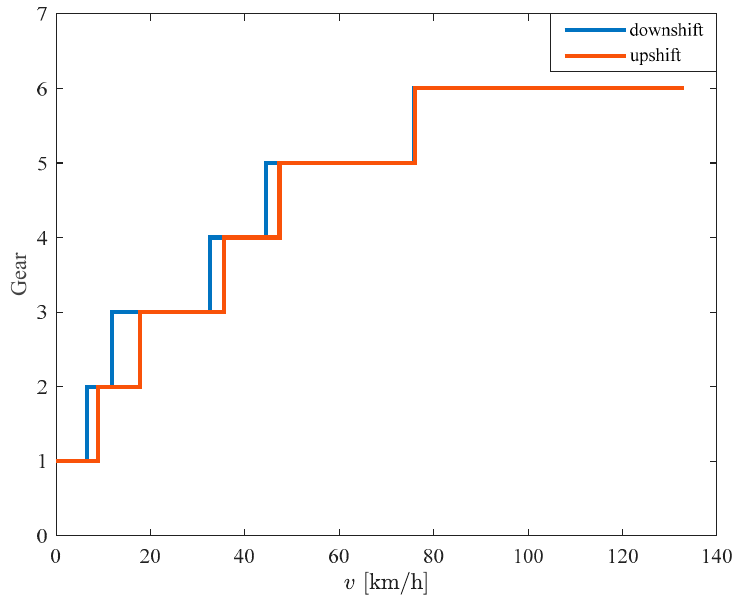
Figure 3. Speed dependent gearshift logic.